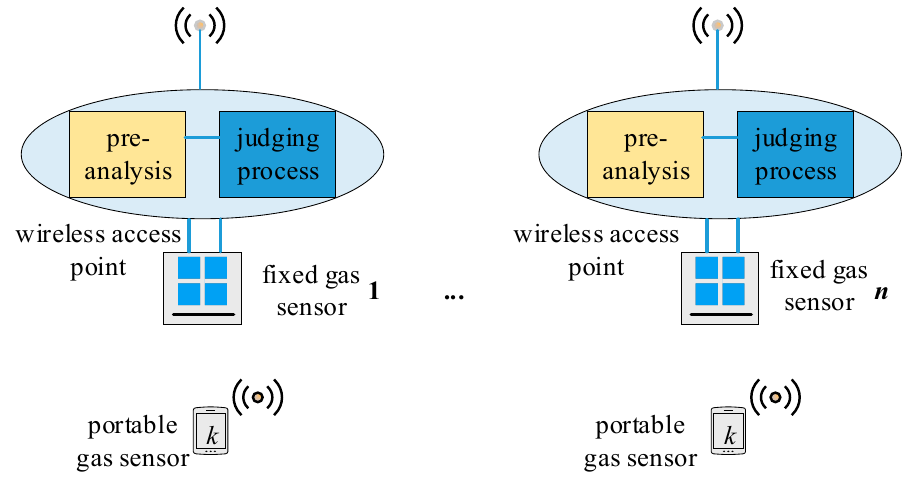
Figure 5. Scene of “single-point, multi-position”. Reasoning Process: Algorithm 2. Multi ‐ period single sensor reliability fusion algorithm.